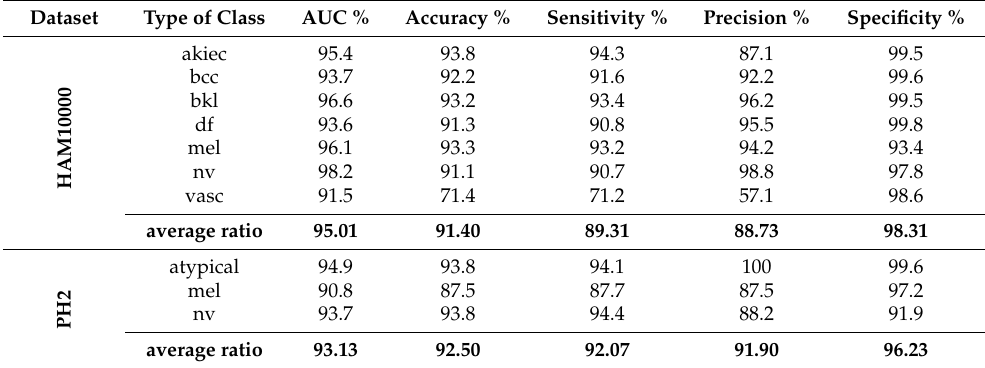
Table 4. Performance of ResNet101 for dermoscopic image analysis to classify skin lesions in HAM10000 and PH2